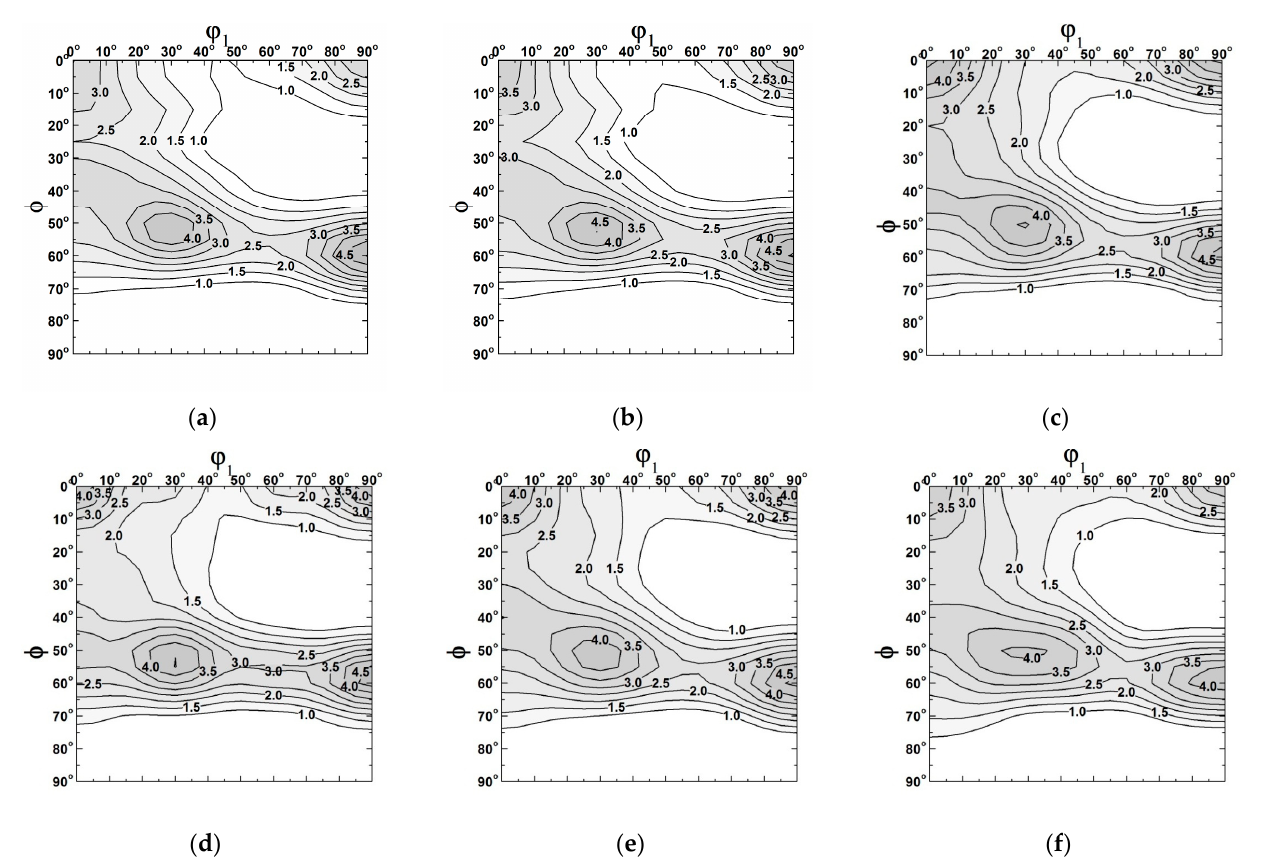
Figure 9. Comparison of orientation density function (ODF) at φ 2 = 45° section of martensite layers in multilayered steel obtained at a kernel resolution of 5°: ( a ) WOMBAT angle dispersive neutron diffraction, Rietveld texture analysis, k 1 = 4.08 Å − 1 ; ( b ) WOMBAT dual wavenumber angle dispersive neutron diffraction, Rietveld texture analysis, k 1 = 4.08 Å − 1 and k 2 = 2.61 Å − 1 . ( c ) TAKUMI time-of-flight neutron diffraction, Rietveld texture analysis [31]; ( d ) iMATERIA time-of-flight neutron diffraction, Rietveld texture analysis [32]; ( e ) RESA-2 angle-dispersive neutron diffraction with 1-D position-sensitive detector, single peak fitting [23]; ( f ) MUSASI-L angle dispersive neutron diffraction with a single tube detector, background-corrected diffraction intensity [23].